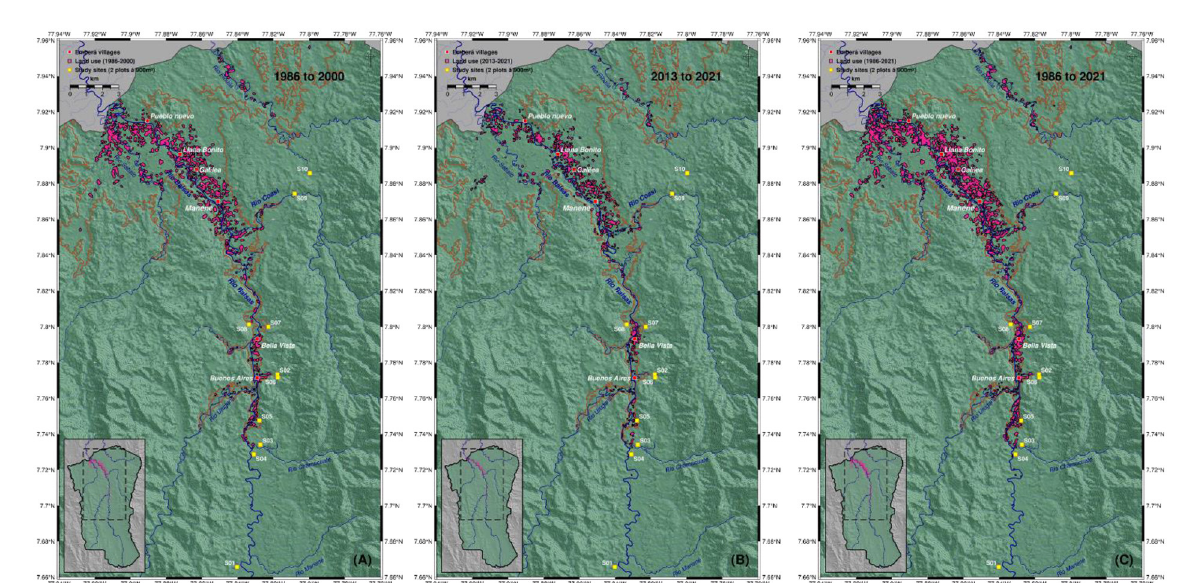
FIGURE6 Areas of identifiably bare soil exposure (as an indicator of land use; pink polygons) in the Emberá ( Tierras Colectivas del Rio Balsas ) territory since 1986. Individual maps show different time periods [ (A) 1986–2000, (B) 2013–2021, (C) 1986–2021] to indicate that areas are frequently reused and mainly bounded to flat terrain below 105m elevation (brown line). Mapping is based on Landsat (4-TM, 5-TM, 7-ETM, 8-OLI) satellite scenes. Also shown are Emberá villages (red squares) and study sites (yellow squares). Background shows hillshaded topography (NASA STRM). Inset map shows the map section (dashed line) within the full territory (green